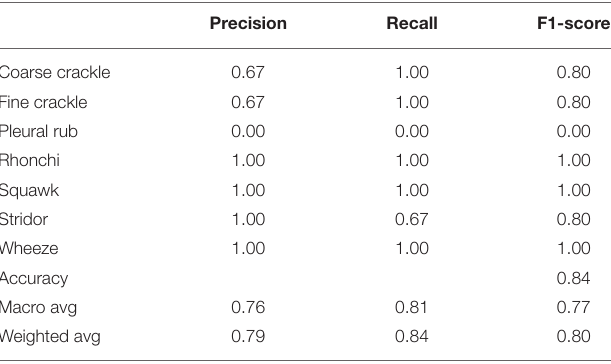
TABLE 3 | Comparative results obtained (Precision and Recall) for VGG-V1. Precision